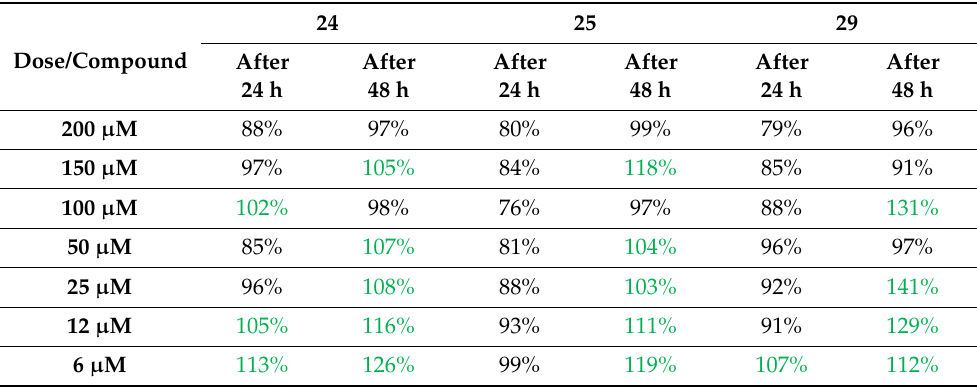
Table 4. The cell proliferation in % according to control after 24 and 48 h exposition on studied compounds in HepG2 cell line.